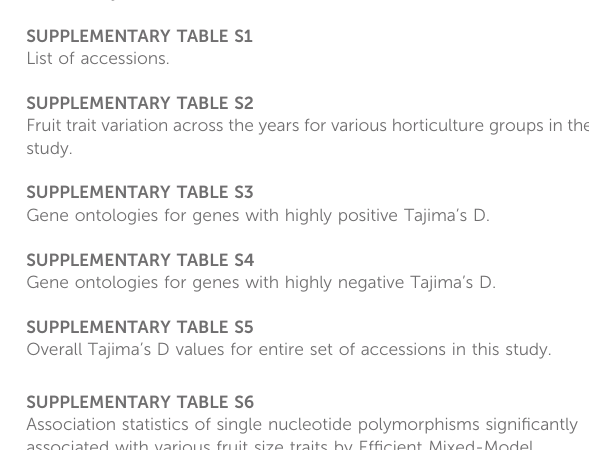
SUPPLEMENTARY FIGURE S2 Box plots for various representative groups (I: Australian, II: Buttercup, Zapallito, Turban, III: Hubbard and Banana and IV: Mammoth) for fruit weight (lbs), fruit length (cm), fruit diameter (cm), ratio of fruit length and diameter and soluble solids (%). SUPPLEMENTARY FIGURE S3 Principal component analysis chart was made using fi rst two eigen vectors involving all the accessions belonging to various groups. SUPPLEMENTARY FIGURE S4 2-kb sliding windows of chromosomes 2, 3, 5, 6, 7, 9, 10, 11, 13, 14, 15, 17, 18, and 19 depicting pairwise F ST s of various groups (I: Australian, II: Buttercup, Zapallito, Turban, III: Hubbard and Banana and IV: Mammoth). SUPPLEMENTARY FIGURE S5 Signi fi cant positive and negative Tajima ’ s D values for the mammoth group across various chromosomes. SUPPLEMENTARY FIGURE S6 Geneontologies(GOs)forvariousgenesunderlyingpositiveandnegative Tajima ’ s D indices. SUPPLEMENTARY FIGURE S7 Box plots of genomewide Tajima ’ s D for groups- I: Australian, II: Buttercup, Zapallito, Turban, III: Hubbard and Banana and IV: Mammoth in the study. SUPPLEMENTARY TABLE S1 List of accessions. SUPPLEMENTARY TABLE S2 Fruit trait variation across the years for various horticulture groups in the study. SUPPLEMENTARY TABLE S3 Gene ontologies for genes with highly positive Tajima ’ s D. SUPPLEMENTARY TABLE S4 Gene ontologies for genes with highly negative Tajima ’ s D. SUPPLEMENTARY TABLE S5 Overall Tajima ’ s D values for entire set of accessions in this study. SUPPLEMENTARY TABLE S6 Association statistics of single nucleotide polymorphisms signi fi